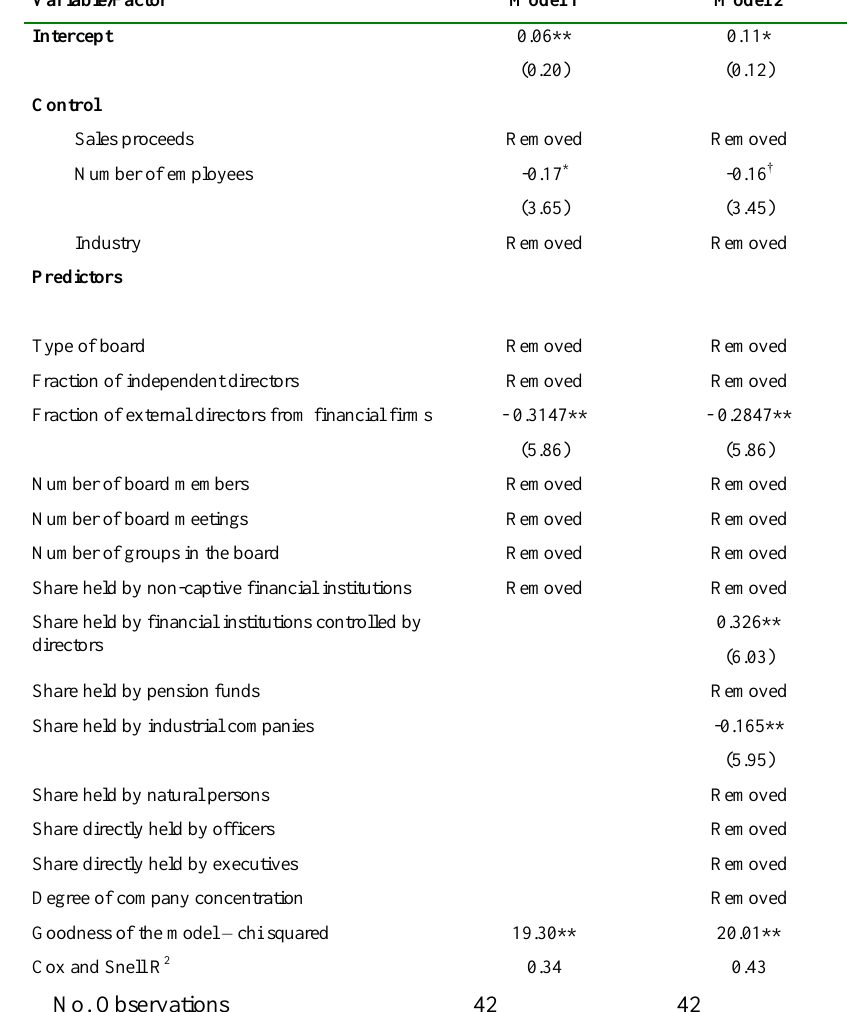
Table 5: Logit Regression